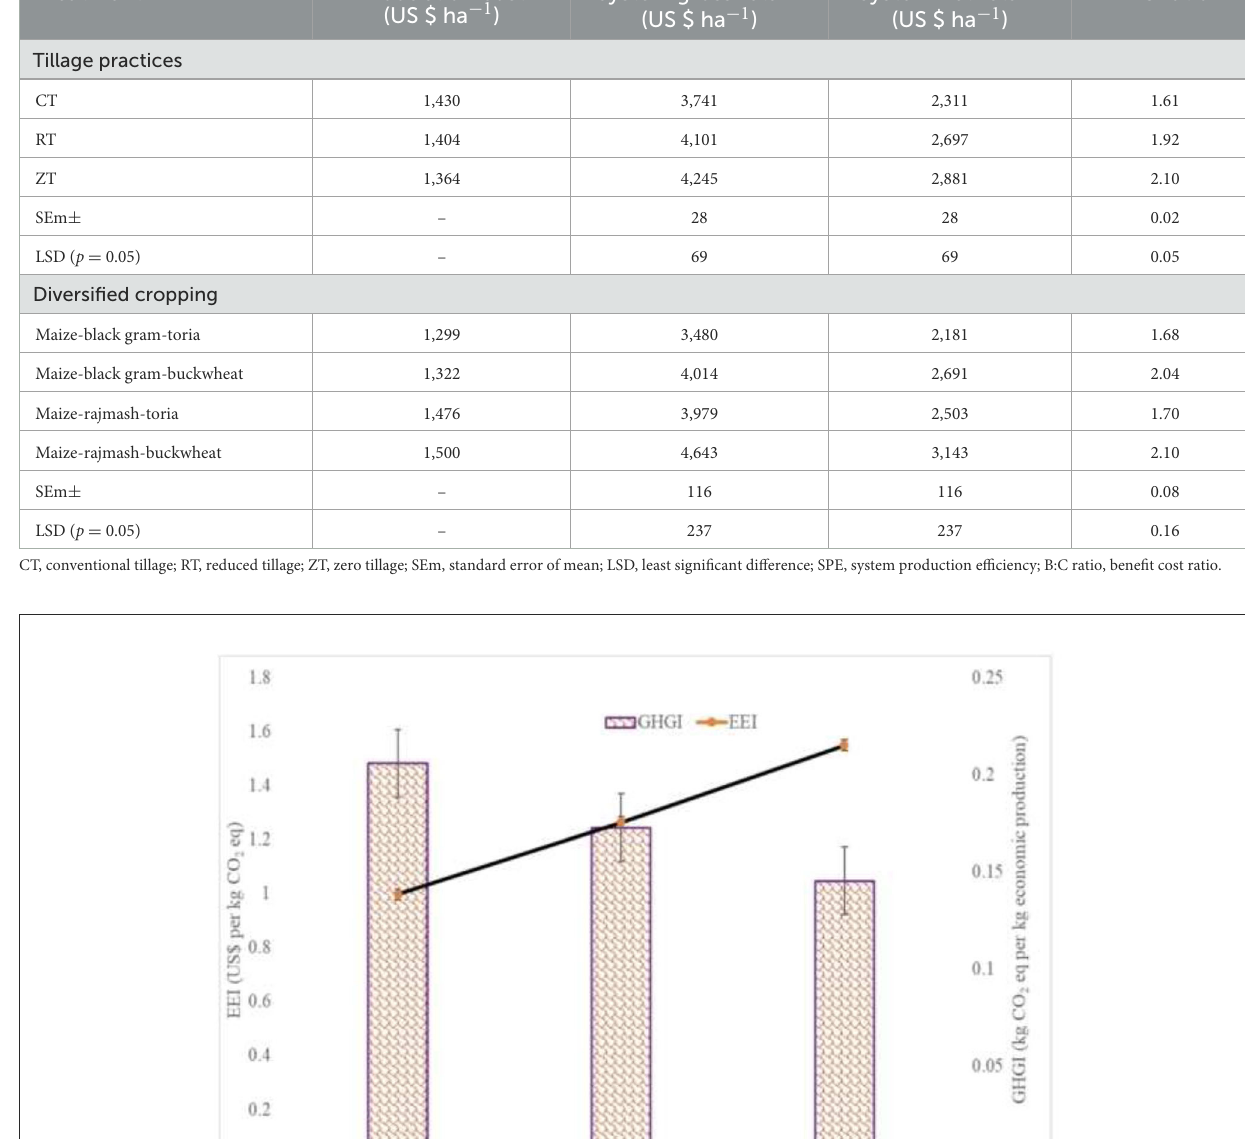
TABLE 2 Impact of different tillage practices and diversified cropping on economic returns (mean of 3 years). Treatment